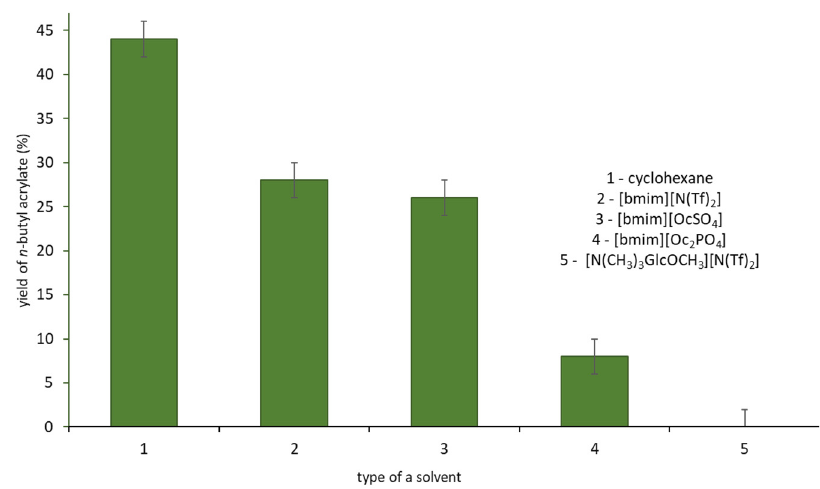
Figure 1. The yield of n -butyl acrylate in the esterification of AA with n -BuOH in the presence of native CALB in various solvents. Reaction conditions: AA 0.072 g (1 mmol), n -BuOH 0.149 g (2 mmol), solvent 1 mL, CALB 0.100 g, 24 h, 25 °C, 250 rpm.